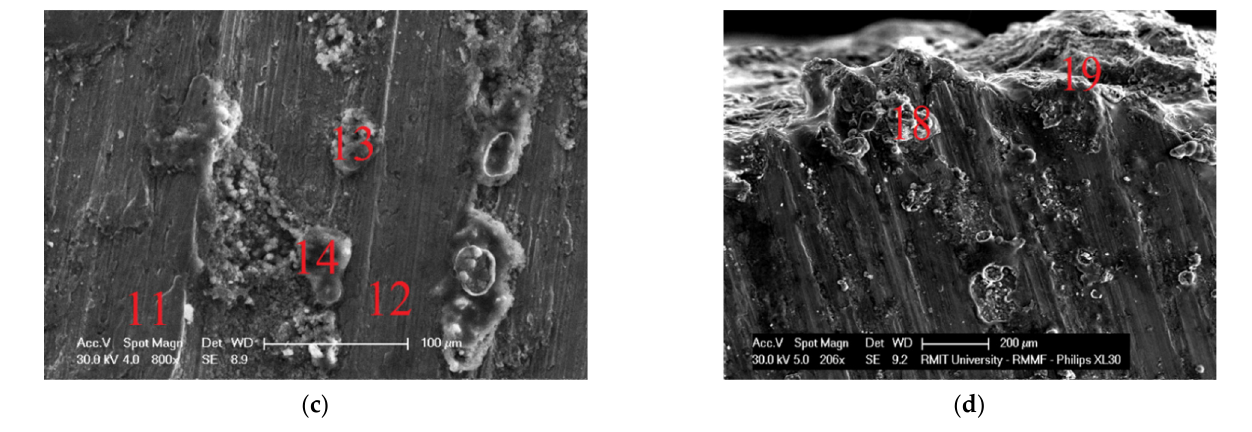
Figure 15. SEM images. ( a ) and ( b ) surface and ( c ) and ( d ) cross section .